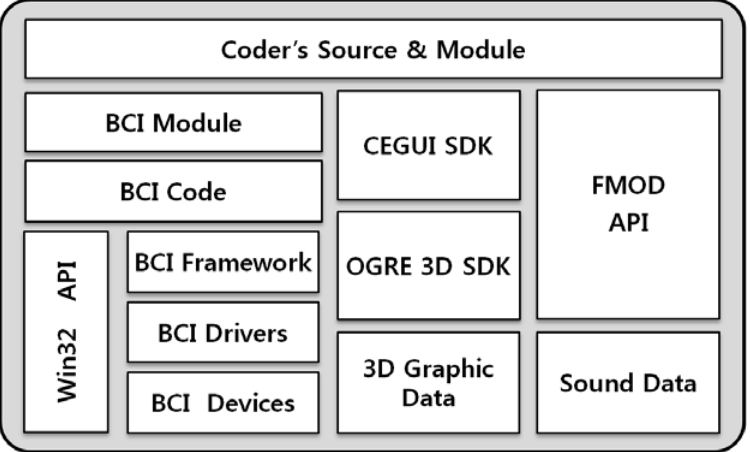
Figure 10. Relationship between BCI Code and Modules. BCI serious games are developed using BCI code, a BCI module, and diverse